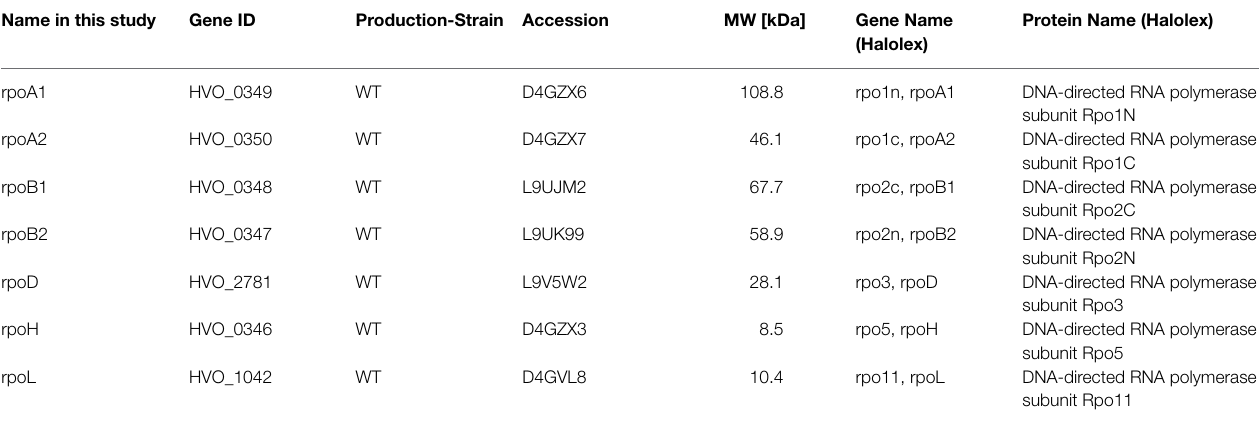
TABLE 2 | Overview of rpo-genes and strains used in this